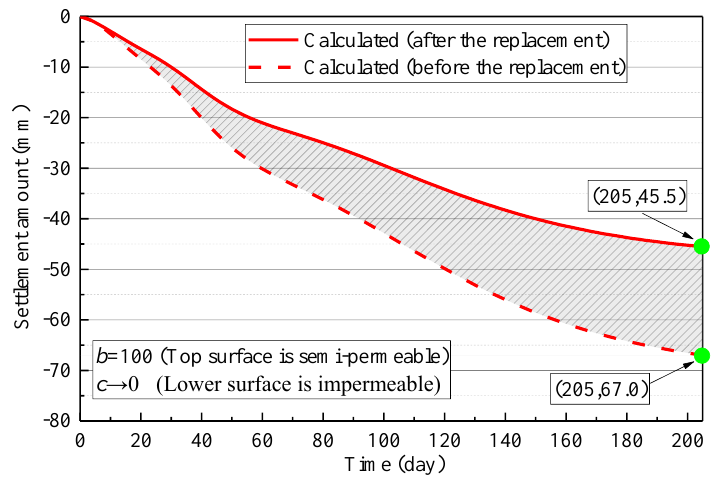
Figure 11. Comparison of the calculated settlement curve before and after the replacement.